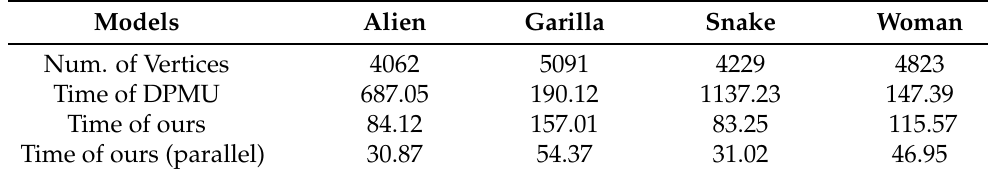
Table 2. Runing time of examples in Figure 7 (Unit: second).